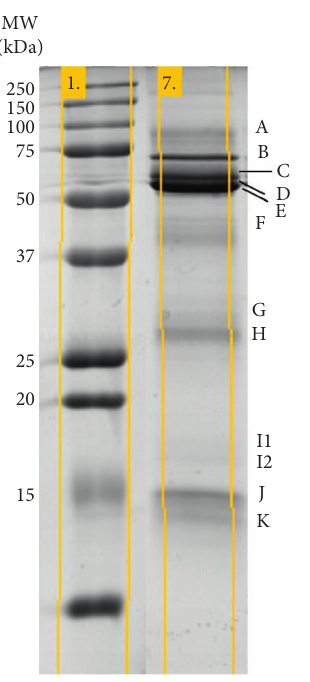
Figure 1: Representative SDS-PAGE salivary profile showing the 12 protein bands consistently present in the different individuals studied (letters on the right side); MW, molecular mass